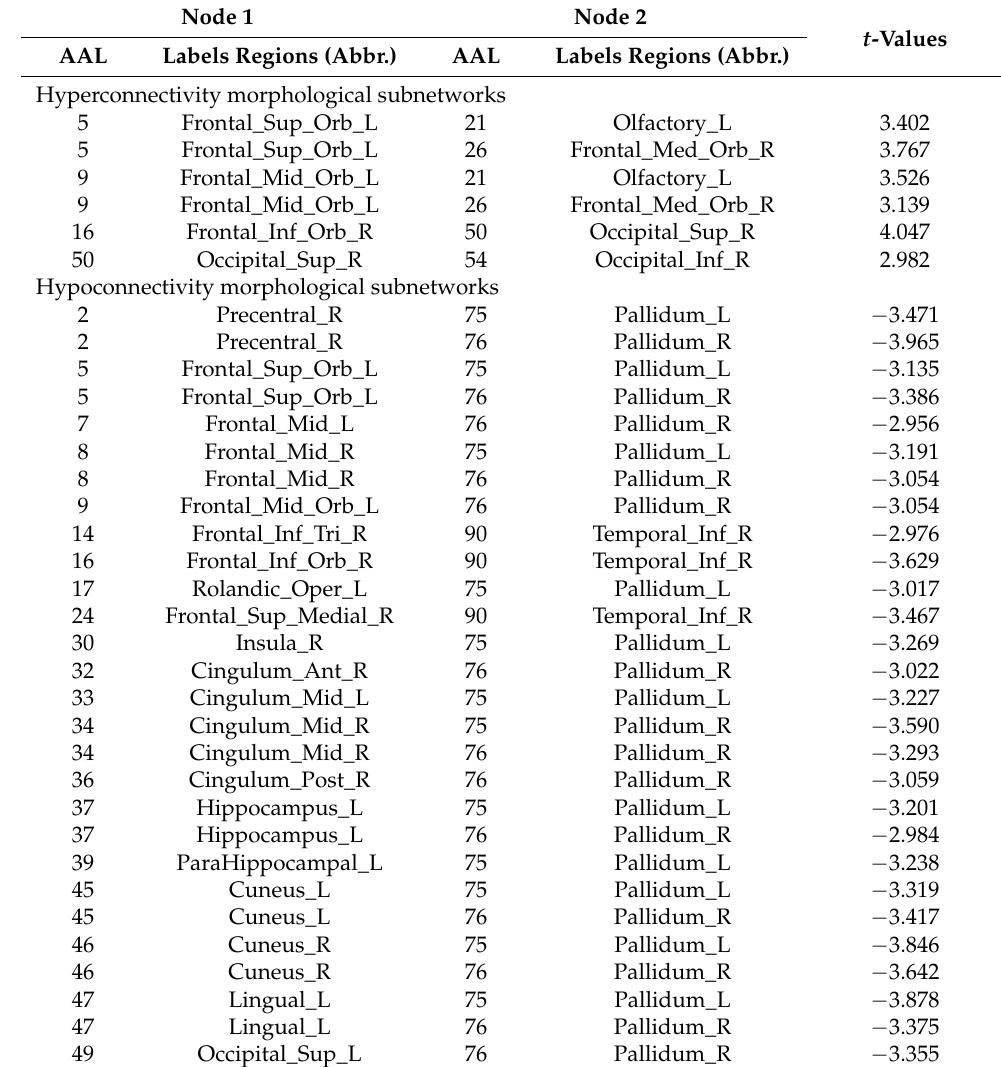
Table A2. Altered connections in the young survivors of ALL based on network-based statistics ( p < 0.05 with